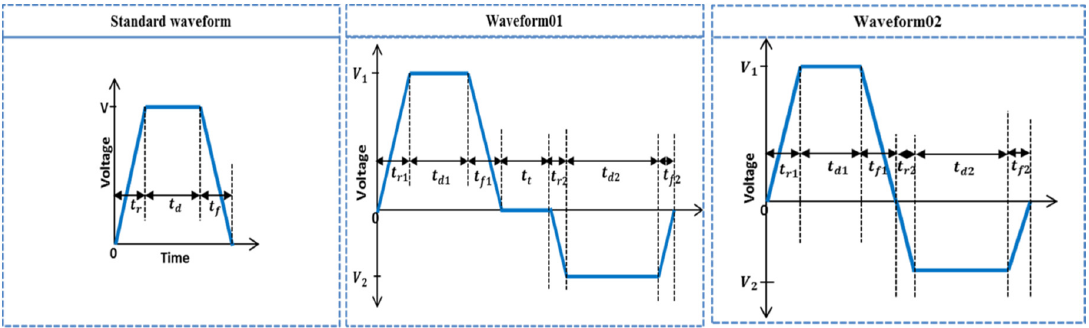
Figure 3. Analyzed waveforms in the present study.